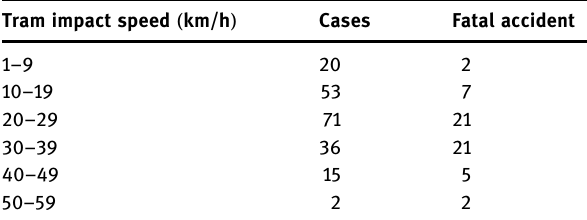
Table 1: Distribution of the fatal accidents Tram impact speed ( km/h ) Cases